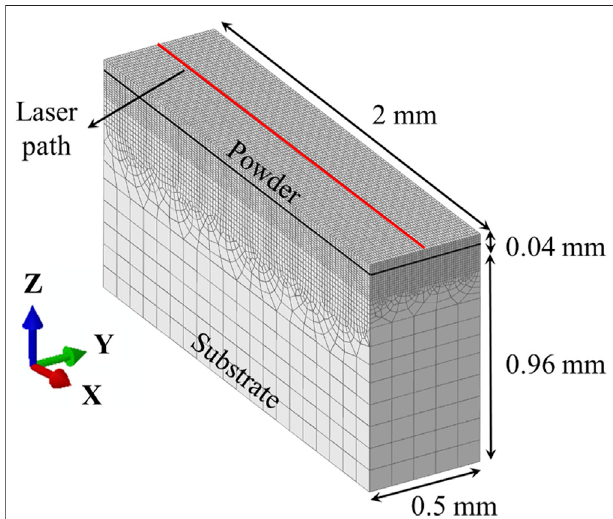
FIGURE 2 | Meshed 3D model for the FE simulations. The powder layer and substrate are 0.04 and 0.96 mm thick, respectively. Mesh sizes for the powder are fi ner (10 µm) compared to the substrate to increase computational ef fi ciency. The red line along the X direction shows the laser path where the nodal temperatures are